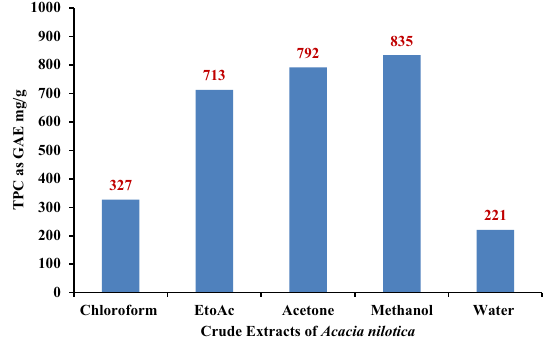
Figure 3. Total Phenolic Content of different crude extracts from bark of Acacia nilotica in mg/g as GAE (Gallic acid equivalent).